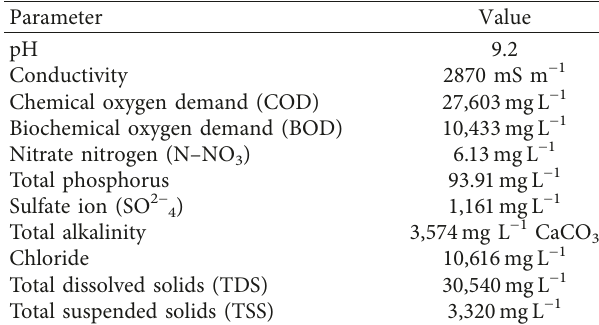
Table 1: Physicochemical parameters of the PWW used as substrate.